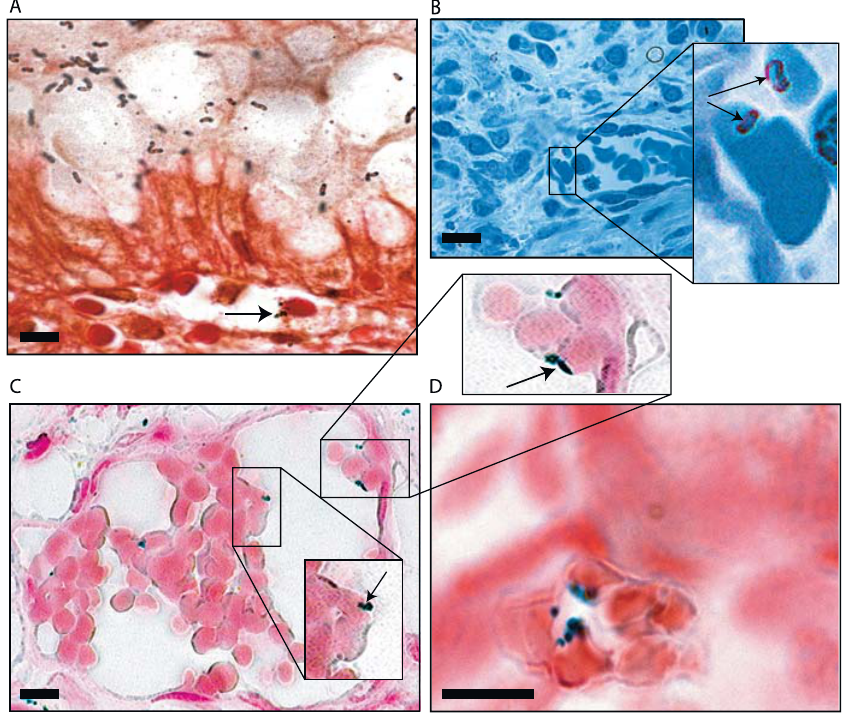
Figure 1. H. pylori Adheres to Erythrocytes in Capillaries and Post-Capillary Venules of Infected Humans and Rhesus Monkeys (A) Genta-stained section of human gastric biopsy. Black spiral- and comma-shaped bacteria are observed in the lumen of the stomach, adherent to gastric epithelial cells, within the mucus globule of the cells. Bacterial cells (arrow) are also present in close contact to an erythrocyte within a capillary located in the supporting connective tissue of lamina propria of the mucosa. (B) Section of human gastric biopsy stained with toluidine blue. A capillary vessel lined by endothelial cells is visible in the lamina propria of the mucosa. It contains several erythrocytes to which H. pylori are attached. Insert: higher magnification of two H. pylori (arrows) in close approximation to erythrocytes. (C) Section of a Rhesus monkey gastric biopsy. In situ hybridization was performed using probes specific for H. pylori 16S rRNA, demonstrating the presence of several H. pylori apparently attached to erythrocyte surfaces of a post-capillary venule located in the lamina propria of submucosa. Inserts: higher magnification of H. pylori bacterial cells (arrows) in close approximation to erythrocytes. (D) Section of a human gastric biopsy. In situ hybridization was performed using probes specific for H. pylori 16S rRNA. This high magnification of a capillary immediately adjacent to a gastric gland (on the top-right corner of the picture) demonstrates the presence of several H. pylori bacterial cells, stained blue, apparently attached to the surfaces of erythrocytes. Bars ¼ 5 l m. DOI: 10.1371/journal.ppat.0020110.g001 PLoS Pathogens |